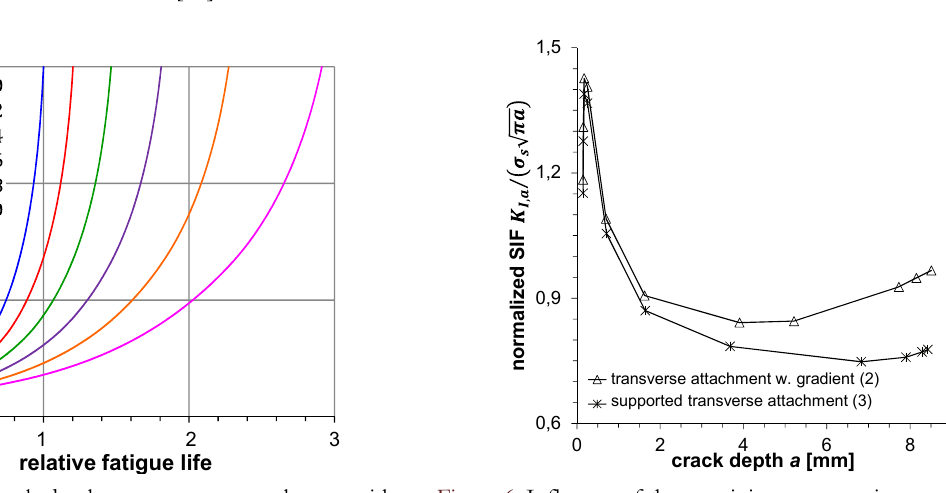
Figure 6: Influence of the remaining cross section on the